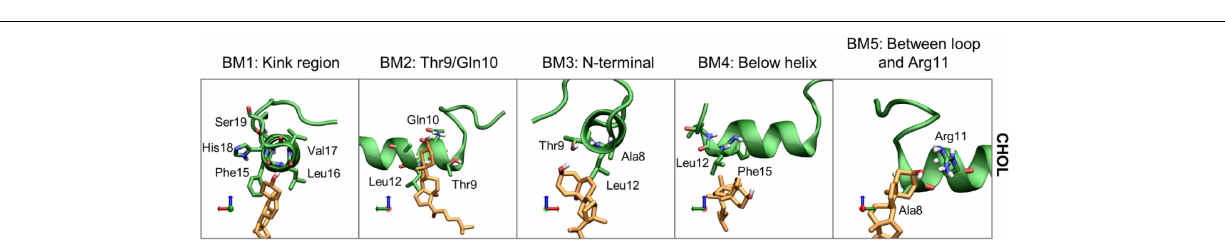
FIGURE 13 | Representative structures of the CHOL binding modes (BM1-5). IAPP is shown in green, with green carbons, and the CHOL is shown with orange